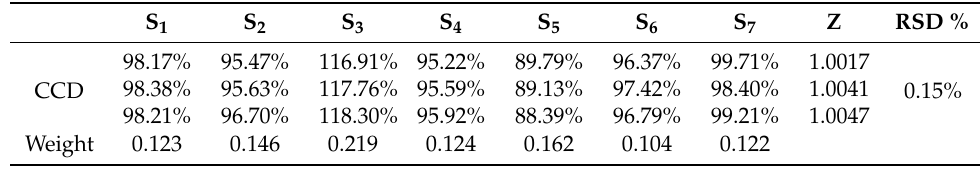
Table 6. Verification of response surface analysis method.